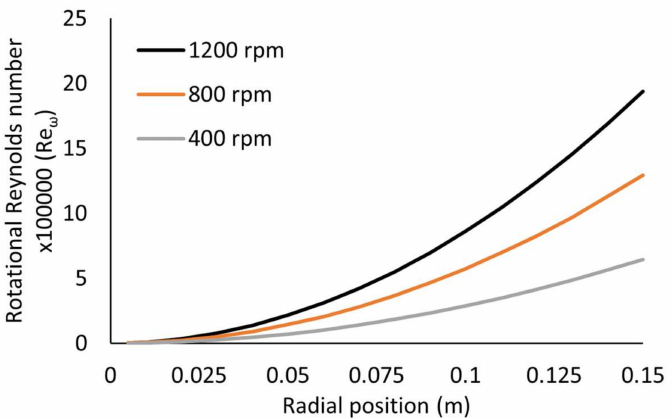
Figure 7. E ff ect of radial position on dimensionless parameters: ( A ) Reynolds number; ( B ) rotational Reynolds number; ( C ) Rossby number at 1200 rpm, 18 mL / s and 9:1 ratio.